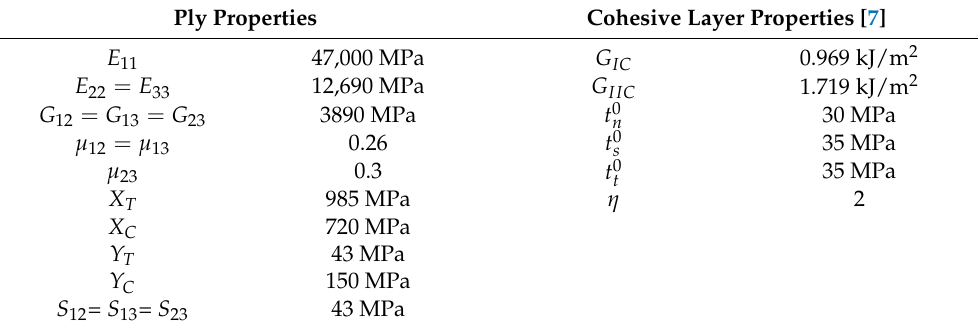
Table 3. Material property of unidirectional laminate. Nomenclature: Young’s modulus ( E ), shear